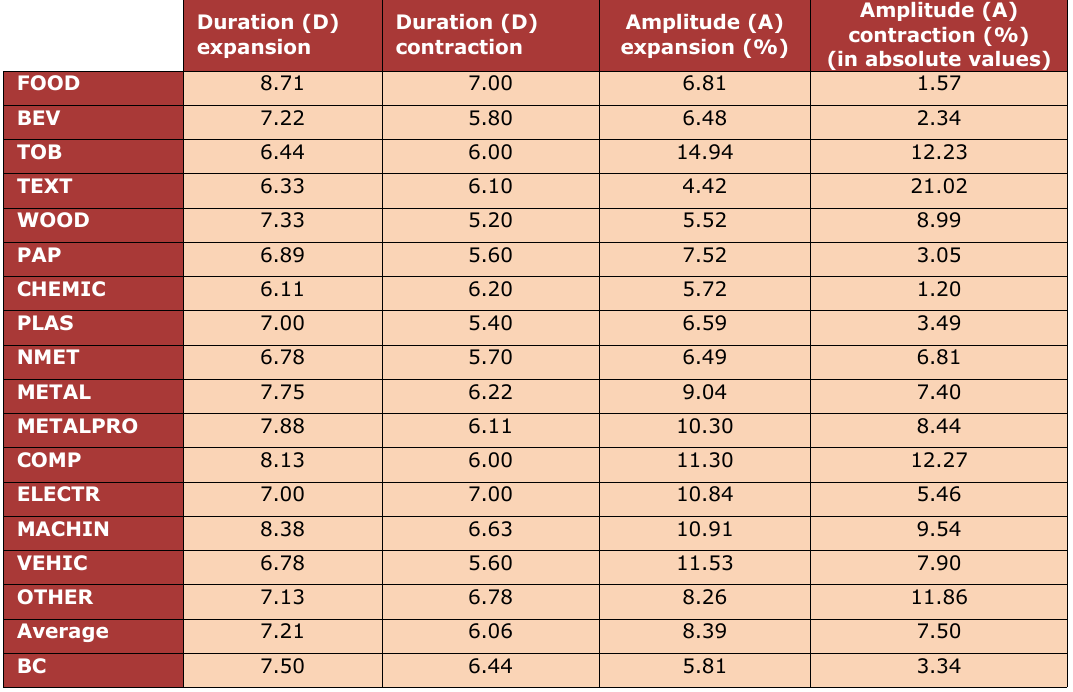
Table 2. Duration and amplitude of cycles phases (average)